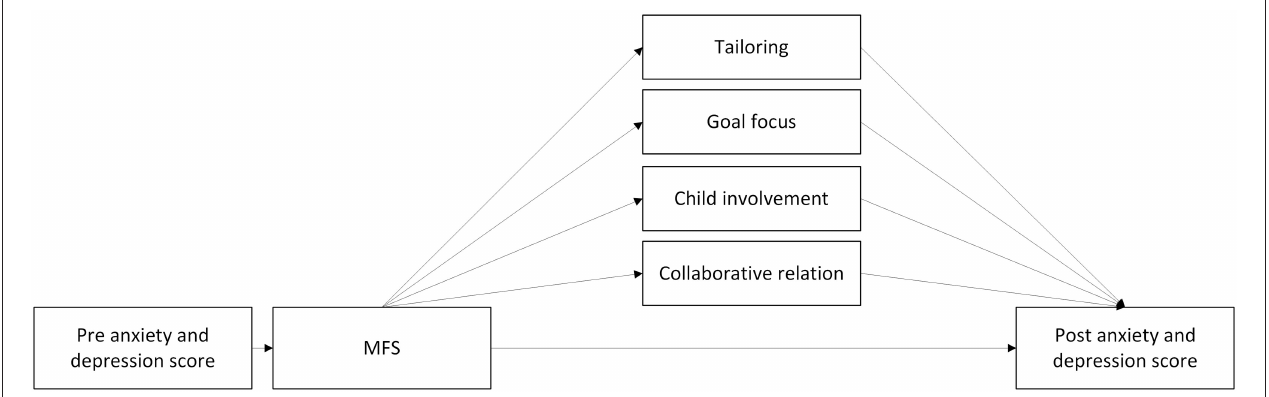
FIGURE 4 | Proposed mediators of change with the measurement feedback system